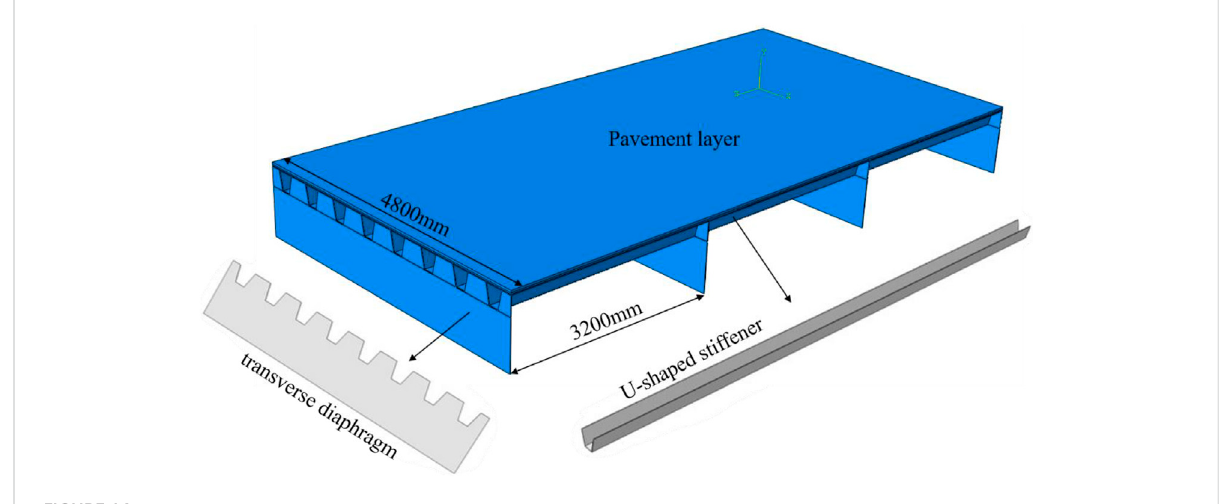
FIGURE 14 Finite element model of the pavement